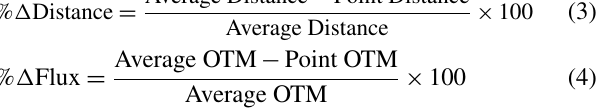
Figure 8. Correlation plot of known release and OTM 33A flux estimate for the METEC test releases. Plot includes OLS (slope = 0 . 92), ODR (slope = 0 . 79), and VWLS (slope = 0 . 67)